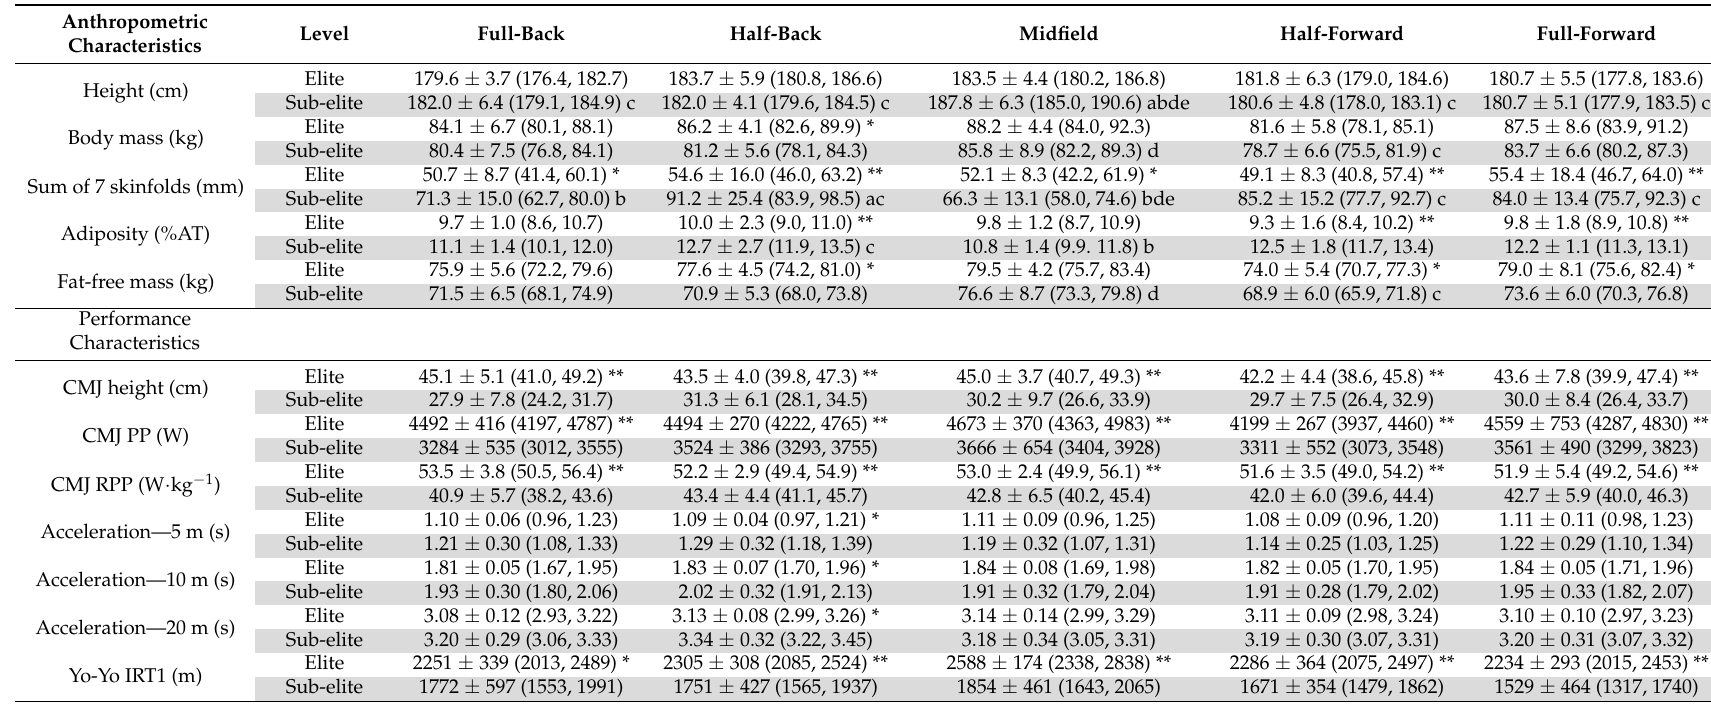
Table 1. Anthropometric and performance profiles of hurlers with respect to position and level of play. Data presented as mean ± standard deviation (SD), 95% confidence intervals. Within the same level, significantly different from a—full-backs; b—half-backs; c—midfield; d—half-forward; e—full-forward. Significant difference between levels at respective positions = * ( p < 0.05), ** ( p <